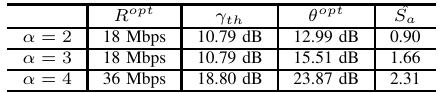
Fig. 4. Throughput with the increasing traffic rate ( α = 3 ). The throughput is improved by the joint optimization of the carrier sensing threshold and transmission rate.